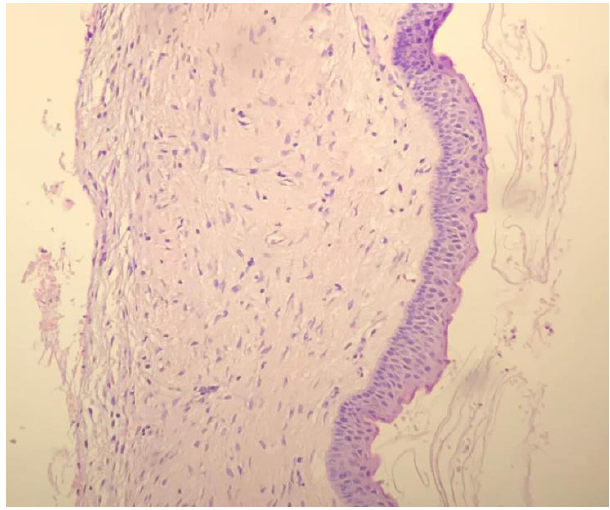
Figure 9. Histologic section of enucleated lesion confirming keratocystic formation (hematoxylin and eosin stain, original magnification 100 × .